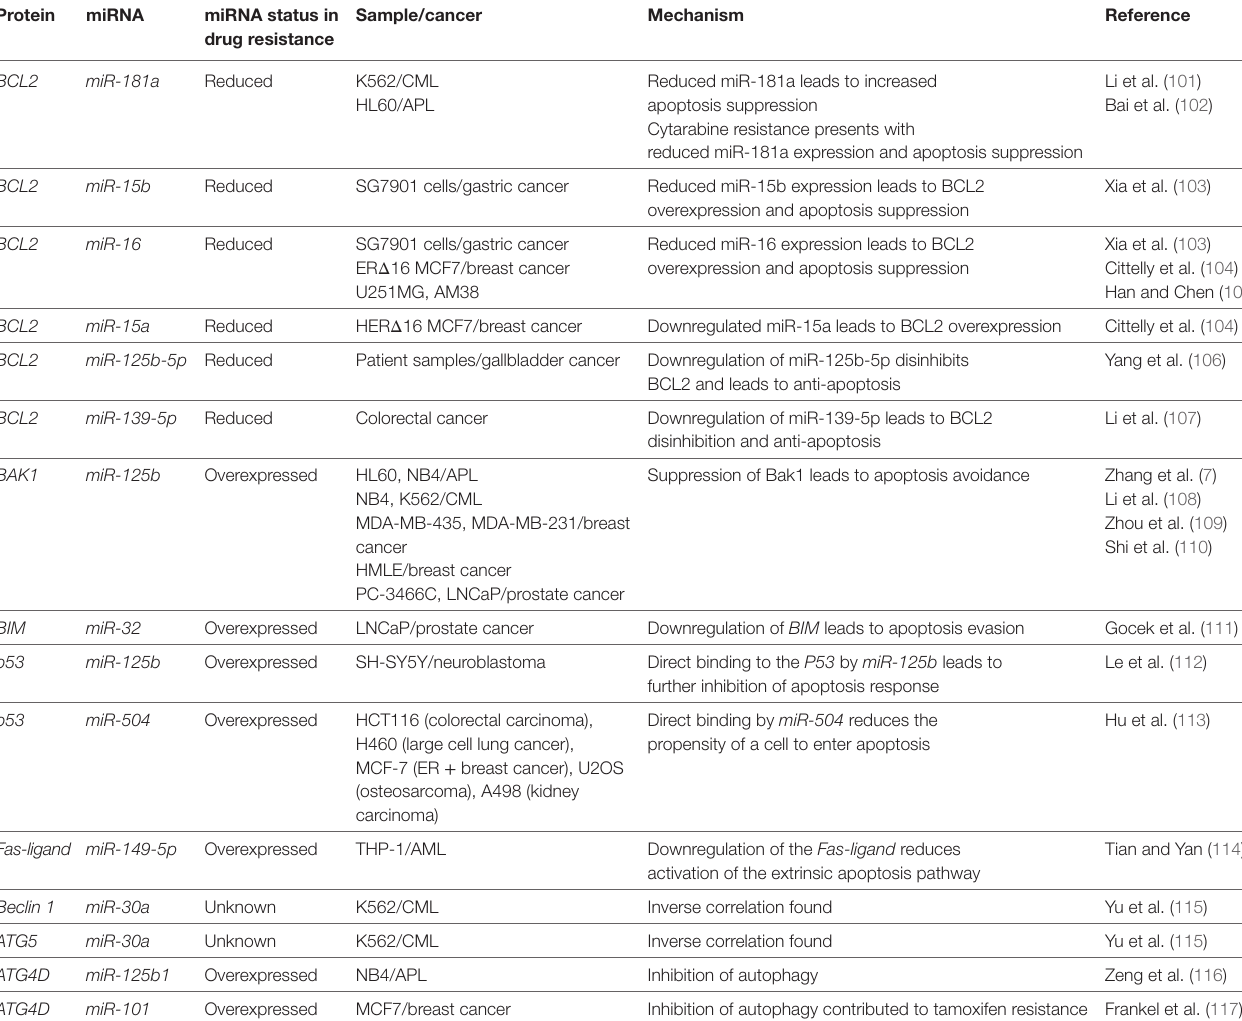
TABLe 3 | The interactions of miRNAs with cell death-related proteins.